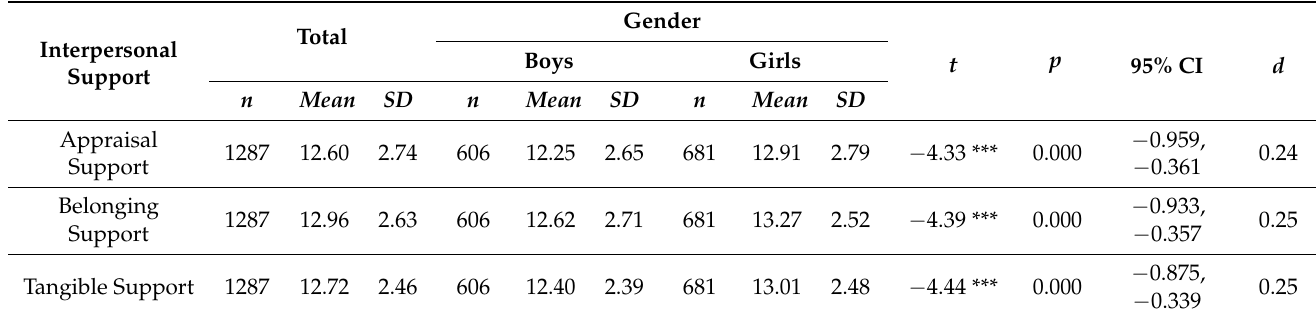
Table 2. Interpersonal support by gender. Descriptive statistics and Student’s t -test.